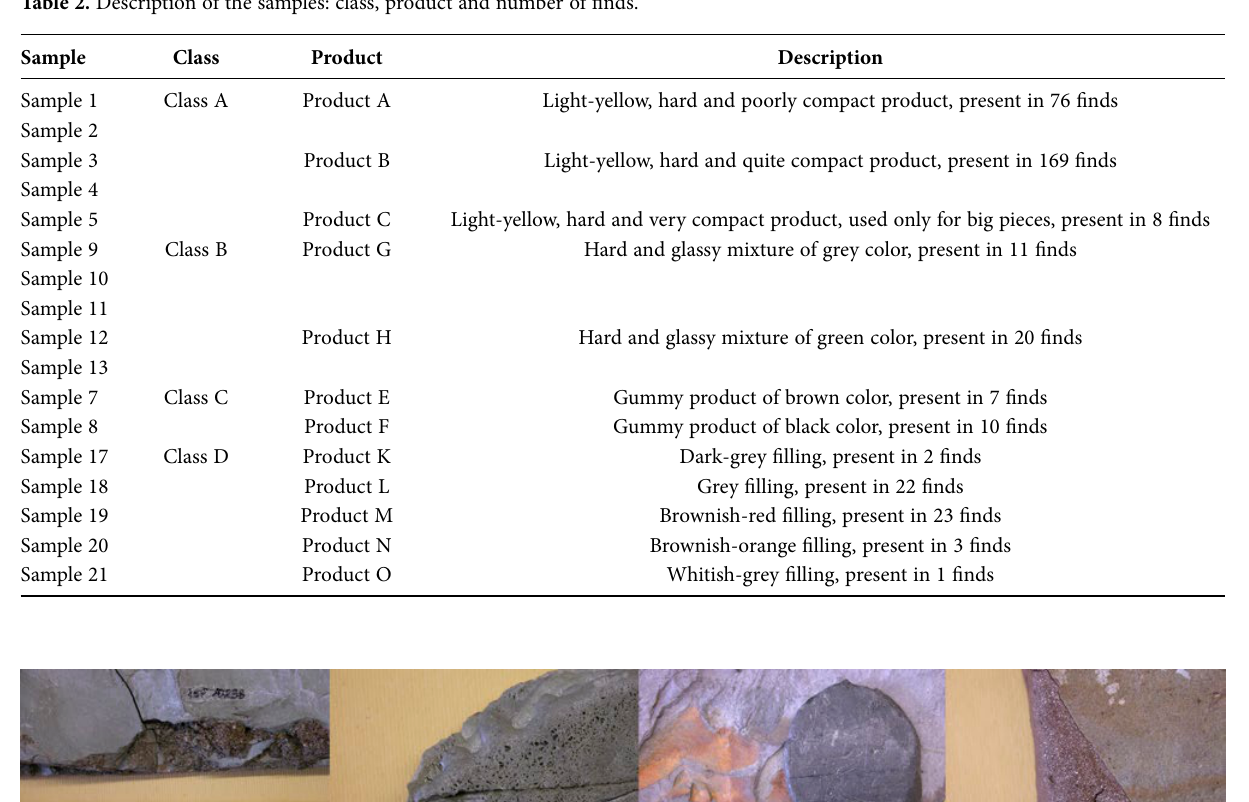
Table 2. Description of the samples: class, product and number of